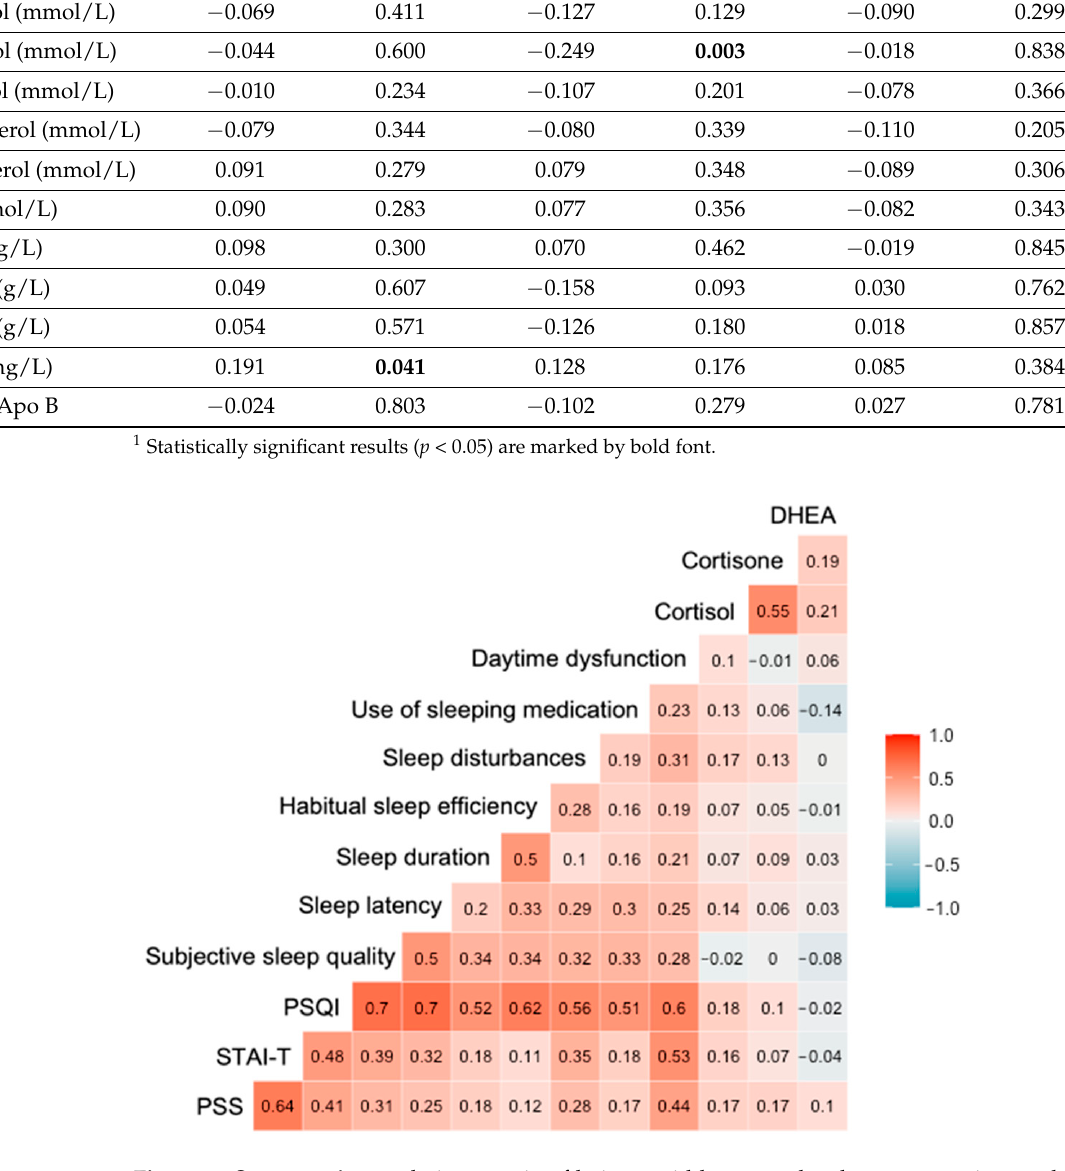
Figure 2. Spearman’s correlation matrix of hair steroid hormone levels, stress, anxiety and sleep quality measures (the intensity of color represents the strength of correlation).